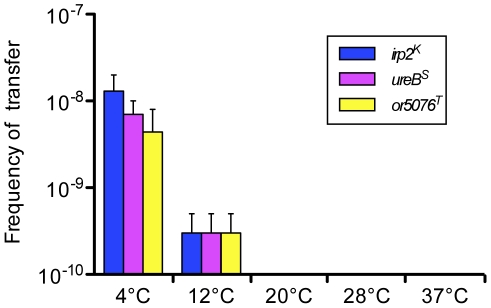
Transfer frequencies at various temperatures of three distantly located chromosomal loci.The donor 637-irp2K-ureBS-5076T and recipient 637ΔHPI-NalR strains were co-incubated in LB-αα' with agitation. Transfer frequency was calculated as the number of NalR (or KanR, SpeR, TmpR) and RifS transconjugants per RifR donor cells. Shown are mean values of transfer frequencies (vertical bars) and standard error of the mean (sem, vertical lines) of two independent experiments at each temperature. Mean transfer frequencies (±sem) at 4°C: 1.3(±0.7)×10−8 for irp2
K, 0.7(±0.3)×10−8 for ureB
S and 0.4(±0.4)×10−8 for or5075
T, and at 12°C: 0.03(±0.02)×10−8 for the three loci. Transfer frequencies at temperatures ≥20°C were systematically below the detection limit (10−10).